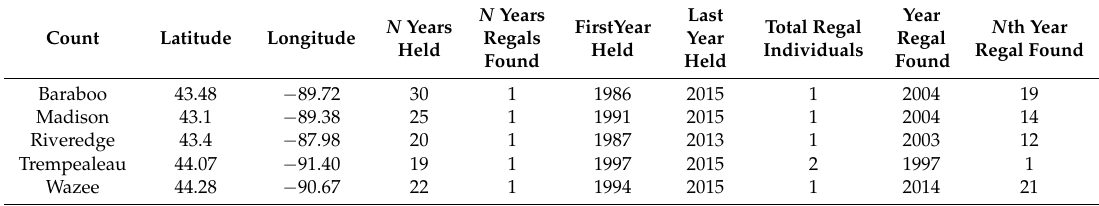
Table 4. Regal fritillary reports in Wisconsin 4th of July Butterfly Counts. See Appendix B for report citations. Roznos Meadows in Devil’s Lake State Park is also reported in the Baraboo count and Stanton Road is reported in the Wazee count (Table 1 and Figure 9). Latitude and longitude are for the center of the 15-mile diameter count